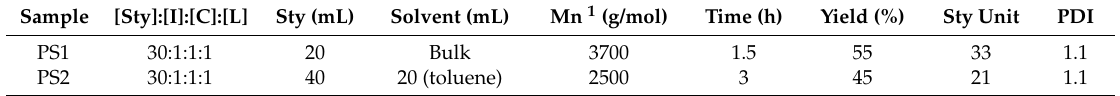
Figure 1. Reaction scheme of the synthesized polymer: ranging from the PS macroinitiator to the final terpolymer. Table 1. Conditions used for ATRP synthesis of two poly(styrene) macroinitiator.